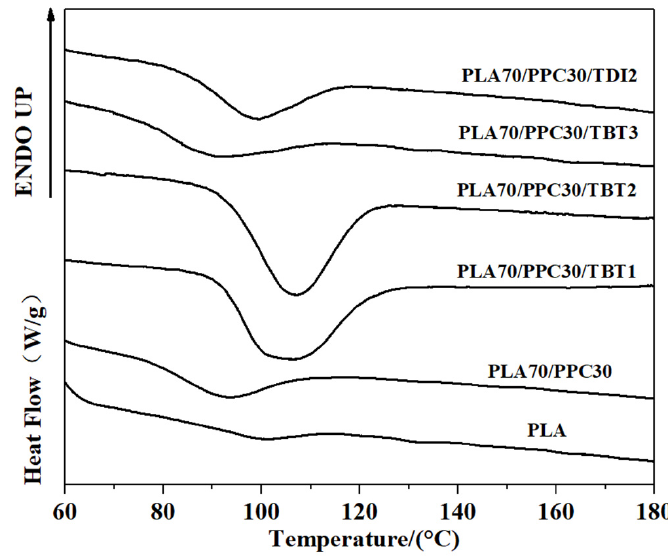
Figure 5. DSC cooling curves of the PLA/PPC blends. Table 4. Crystallization temperature and crystallinity of PLA in the PLA/PPC blends during a cooling process at 10 °C/min.